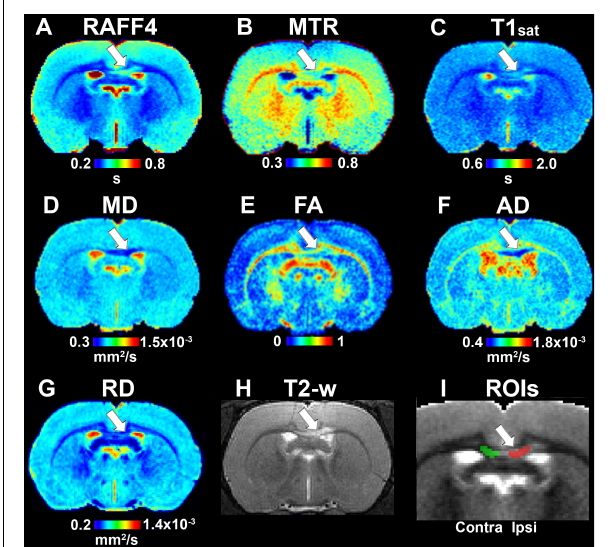
FIGURE 2 | Quantitative MRI maps in the demyelination phase, on day 3: RAFF4 (A) , magnetization transfer ratio, MTR (B) , T1sat (C) , mean diffusivity, MD (D) , fractional anisotropy, FA (E) , axial diffusivity, AD (F) , radial diffusivity, RD (G) , T2w image with lesion (H) and representative example of ROIs for analy z ing the lesion on a grayscale RAFF4 map (I) . White arrow points to the lesion in the corpus callosum.